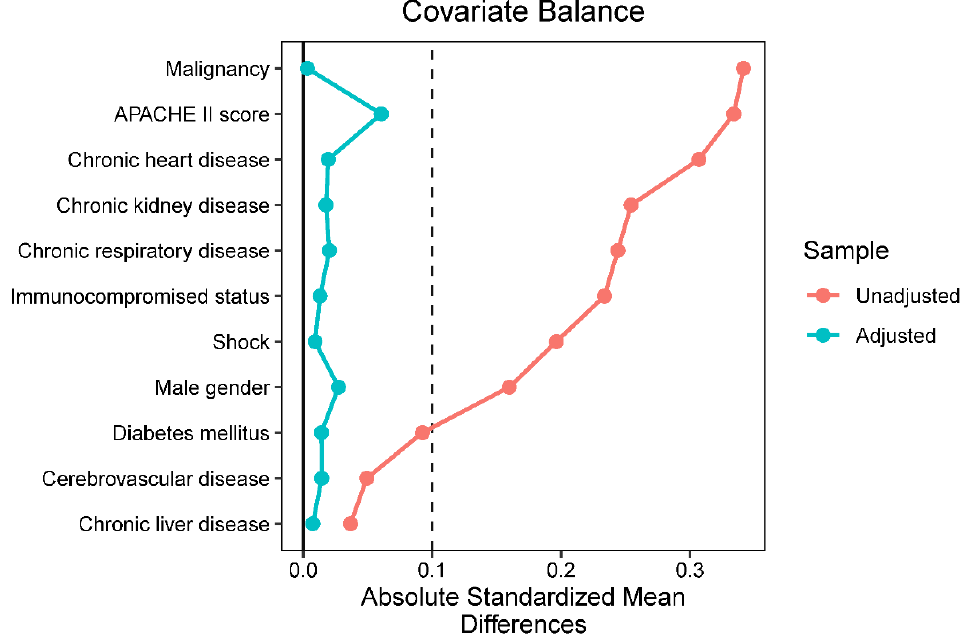
Figure 2. Standardized mean differences (SMD) between patients receiving piperacillin/tazobactam and carbapenems. The red dots represent the SMD in the whole unweighted cohort; the blue dots represent the SMD in the weighted cohort after the inverse probability of treatment weighting.